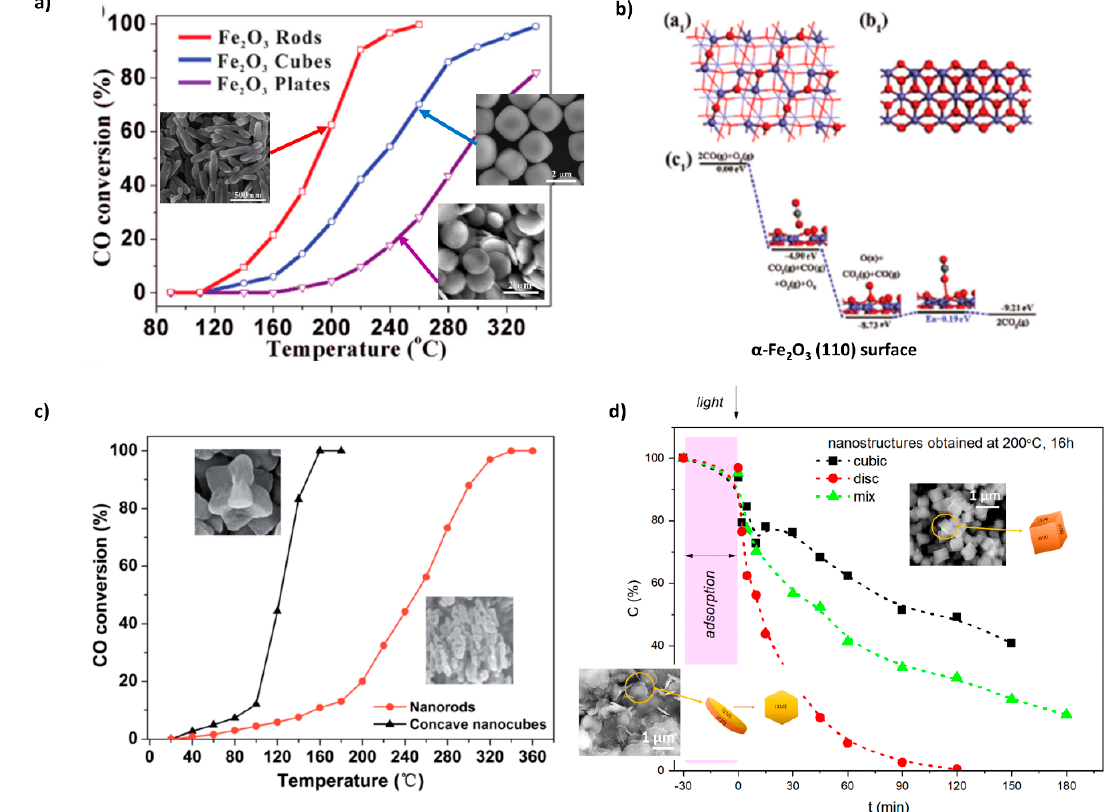
Figure 6. Catalytic activities of hematite: rods, cubes, plates ( a ) with the top and side view of optimized geometric structures of (110) surface with corresponding energy profiles of each elementary step in CO oxidation catalysis ( b ). Reprinted and modified with permission from ref. [175] Catalytic activities of concave nanocubes and nanorods α -Fe 2 O 3 for carbon monoxide oxidation ( c ). Reprinted with permission from ref [124]. Photocatalytic degradation of RhB over the iron oxide various facet-dependent nanostructures ( d ). Reprinted and modified with permission from ref [126]. Then, O 2 chemisorbs at oxygen vacancy site and CO in the atmosphere reacts with this oxygen.